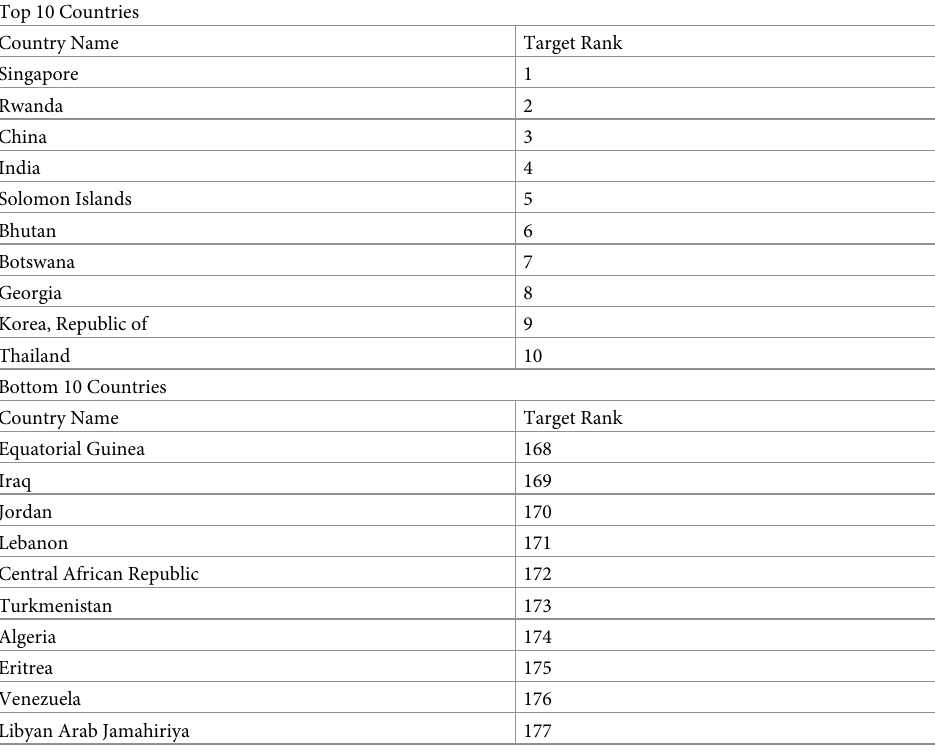
Table 1. The Top 10 and Bottom 10 countries to Target to reduce global toxic and non-toxic pollution